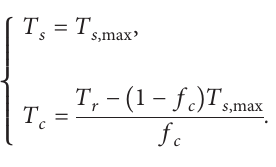
s and LE c ) proposed in this